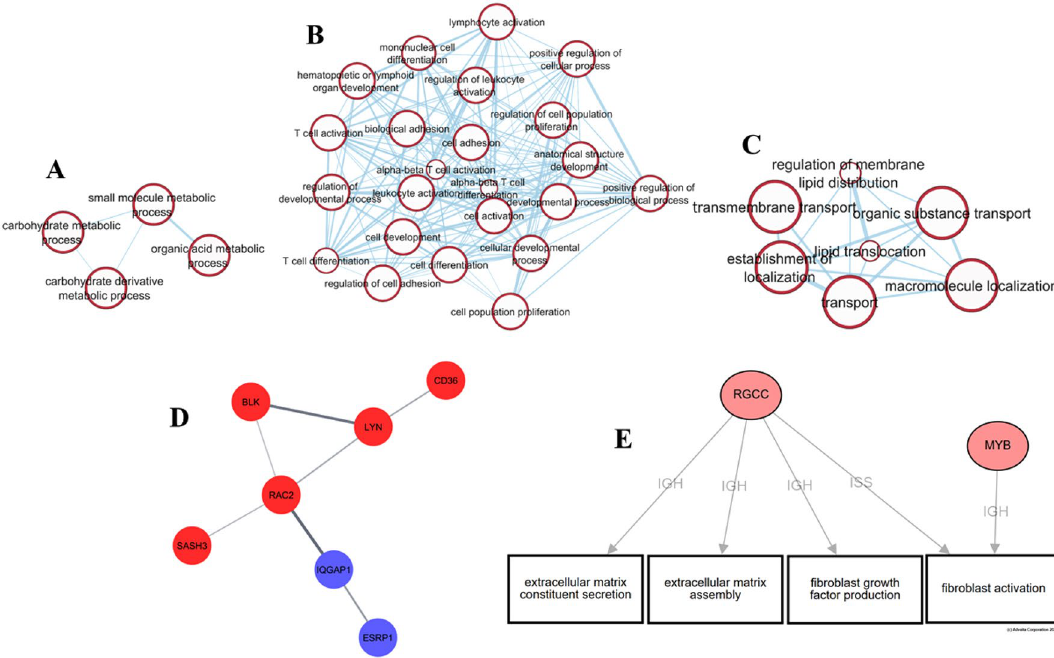
Figure 2. ( A ) Enrichment map of genes upregulated in response to radiation showing GO terms related to carbohydrate metabolism. ( B ) GO terms upregulated in response to radiation, showing enrichment of several immune-related processes such as lymphocyte, leucocyte, and T cell activation (generated using Enrichment map). ( C )Enrichment map of genes upregulated in response to radiation showing changes in lipid transport. ( D ) Protein interaction map generated using STRING of genes from the GO term of immune effector process GO term (GO:0002699) (red) with genes from the response to fibroblast growth factor (GO:0071774) (blue). ( E ) iPathwayGuide network constructed with genes from the Immune processes GO term and BP terms related to ECM and fibroblast